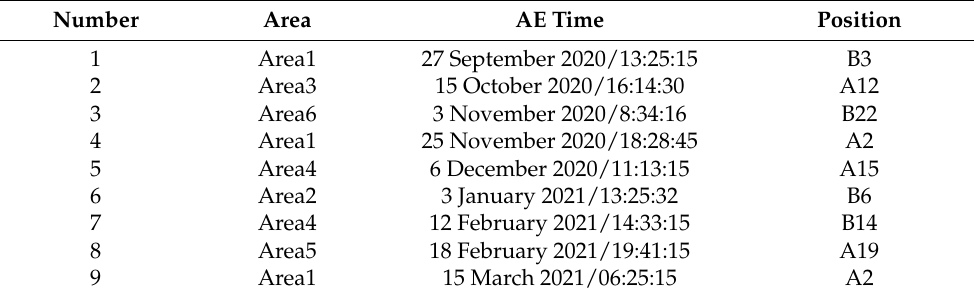
Table 1. 9 groups of anode effect